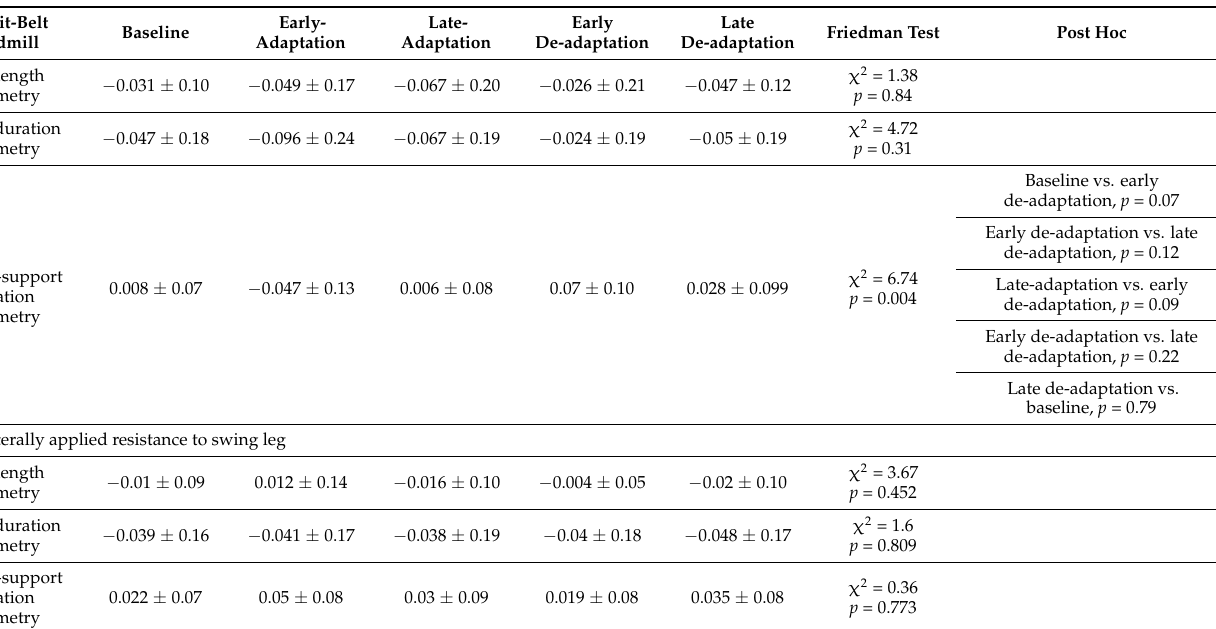
Table 1. Gait symmetry during gait on (1) split-belt treadmill, and (2) unilaterally applied resistance to swing leg. Values presented as mean ±